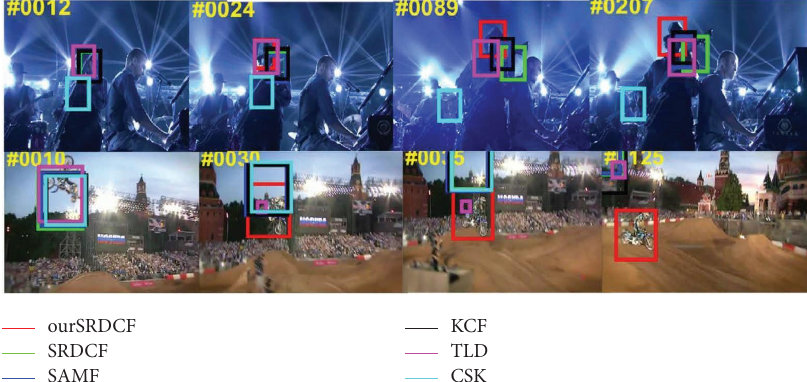
Figure 10: Comparison of tracking results of six algorithms in “shaking” and “motorRolling” video